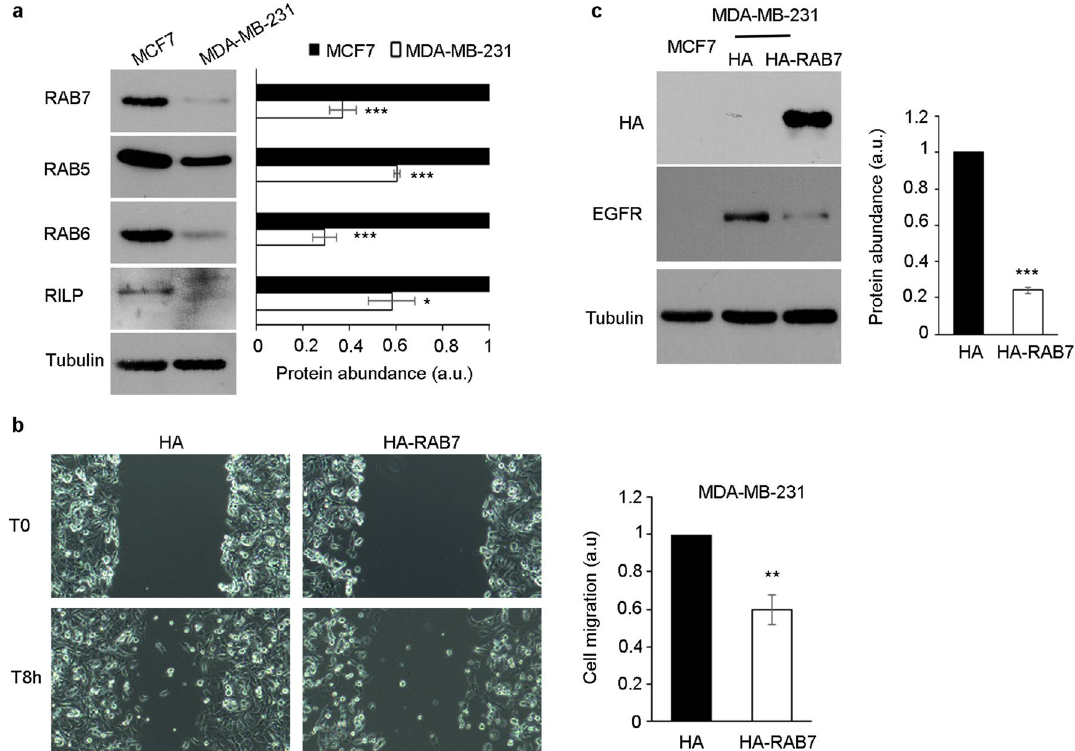
Figure 5. RAB7 in breast cancer cells. ( a ) Lysates of MCF7 and MDA-MB-231 cells were analyzed by Western blot using specific anti-RAB7, anti-RAB5, anti-RAB6, anti-RILP, and anti-tubulin antibodies. Intensities of bands were measured by densitometry and normalized against tubulin. ( b ) MDA-MB-231 overexpressing HA-RAB7 were imaged during wound healing assay at initial time point T0 and 8 h after the scratch. Cell migration was measured as the ratio between the closed area of the wound in control (HA) and HA-RAB7 overexpressing cells. ( c ) MDA-MB-231 overexpressing HA-RAB7 were lysed and analyzed by Western blot using specific anti-HA, anti-EGFR, and anti-tubulin antibodies. Intensities of bands were measured by densitometry and normalized against tubulin. Data represent the mean ± s.e.m. of at least three experiments. Student’s